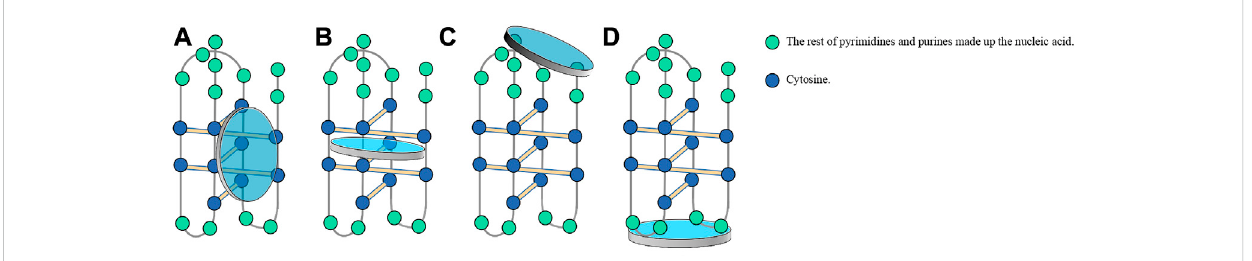
FIGURE 7 Usual modes of ligands binding to the i-motif. (A) Binding to the major external groove of the i-motif owing to large steric hindrance and ionic strength. (B) Embedding in C-C + base pairs by π - π stacking. (C) Stacking at two ends of the i-motif in the presence of Van der Waals and electrostatic forces. (D) Binding to hairpin species in the central loop region of the i-motif due to steric hindrance and molecular